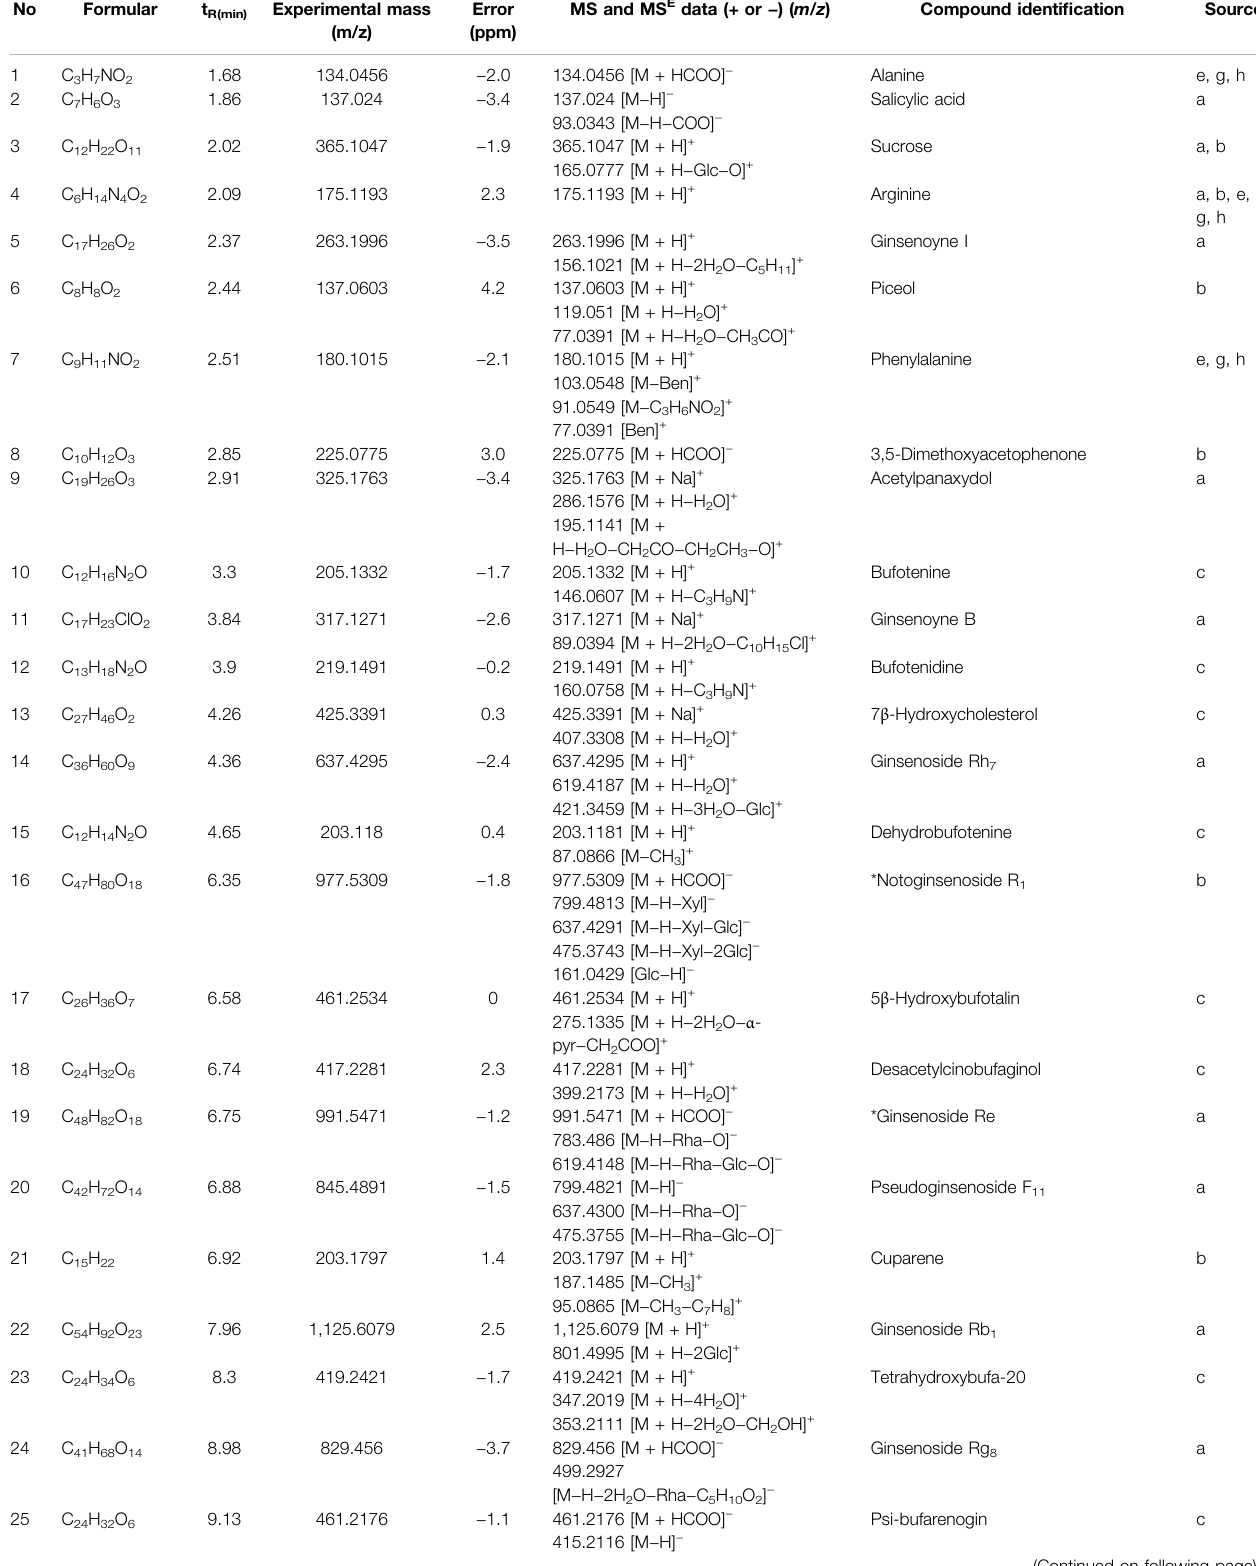
TABLE 1 | Identi fi cation of chemical constituents of HJP by UPLC/Q − TOF − MS E